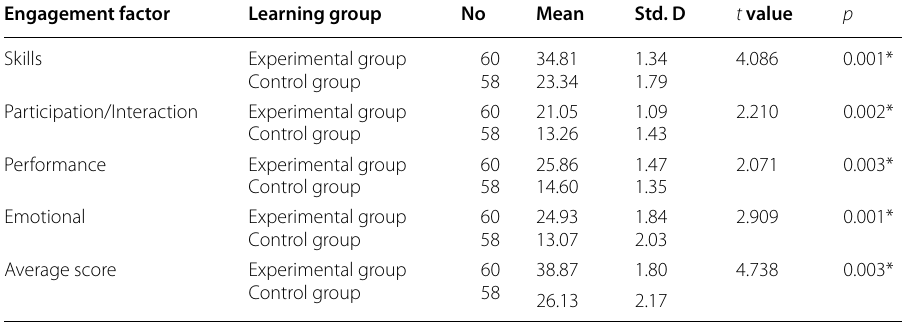
* p < 0.05, *Significant at 0.05